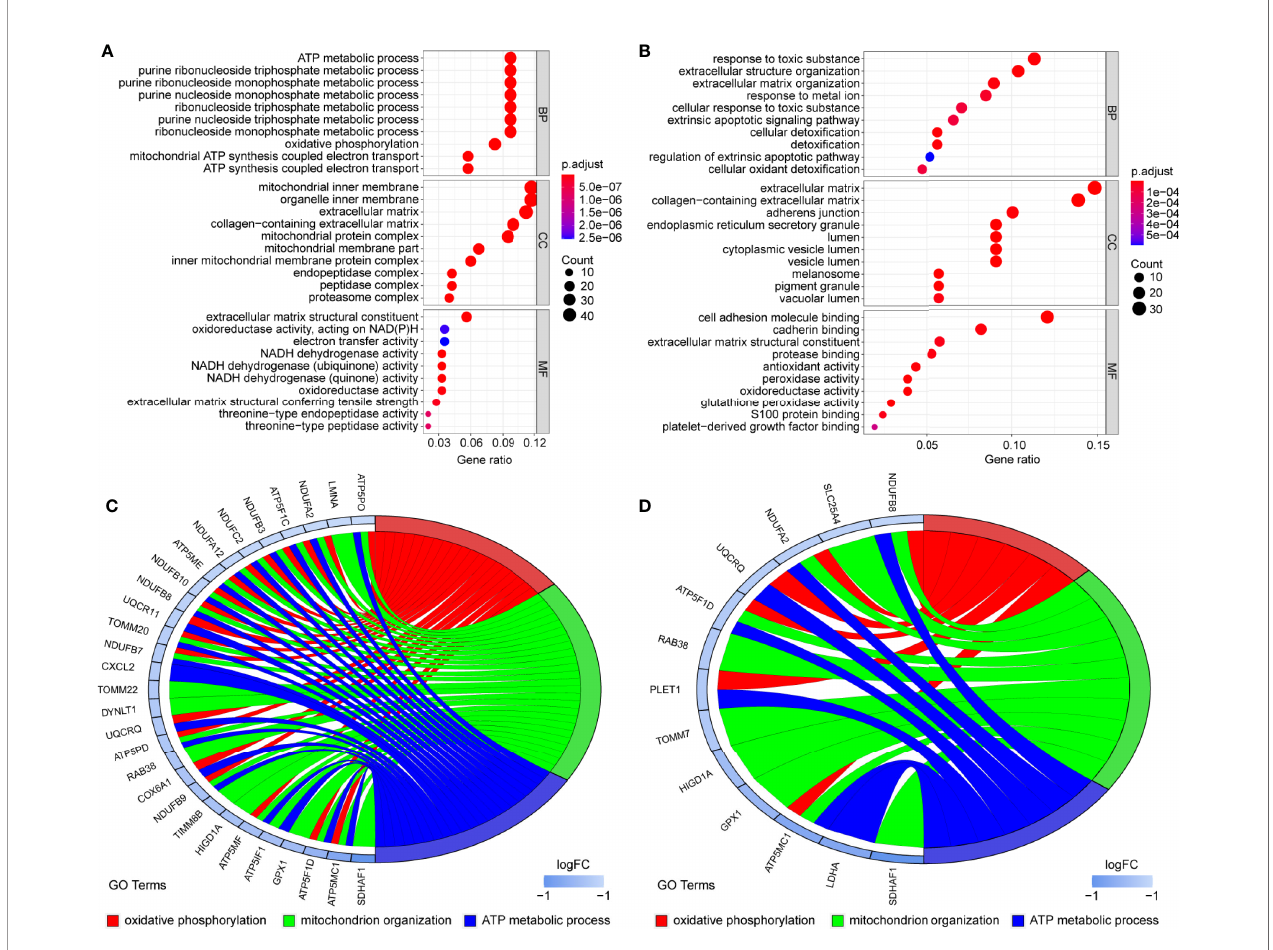
FIGURE 6 | Gene markers and functional analysis of each nucleus pulposus (NP) cell cluster. Bubble plots showing GO/pathway analysis results of marker genes in NP cell cluster 1 (A) and cluster 2 (B) . The chord plots reveal highly relevant functions and genes assigned to NP cell cluster 1 (C) and cluster 2 (D)